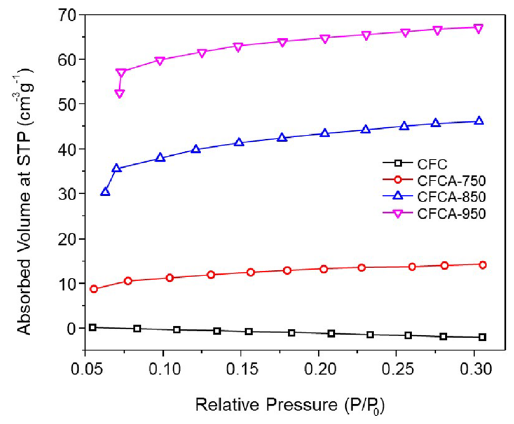
Fig. 3 N 2 adsorption of keratin and CFCAs